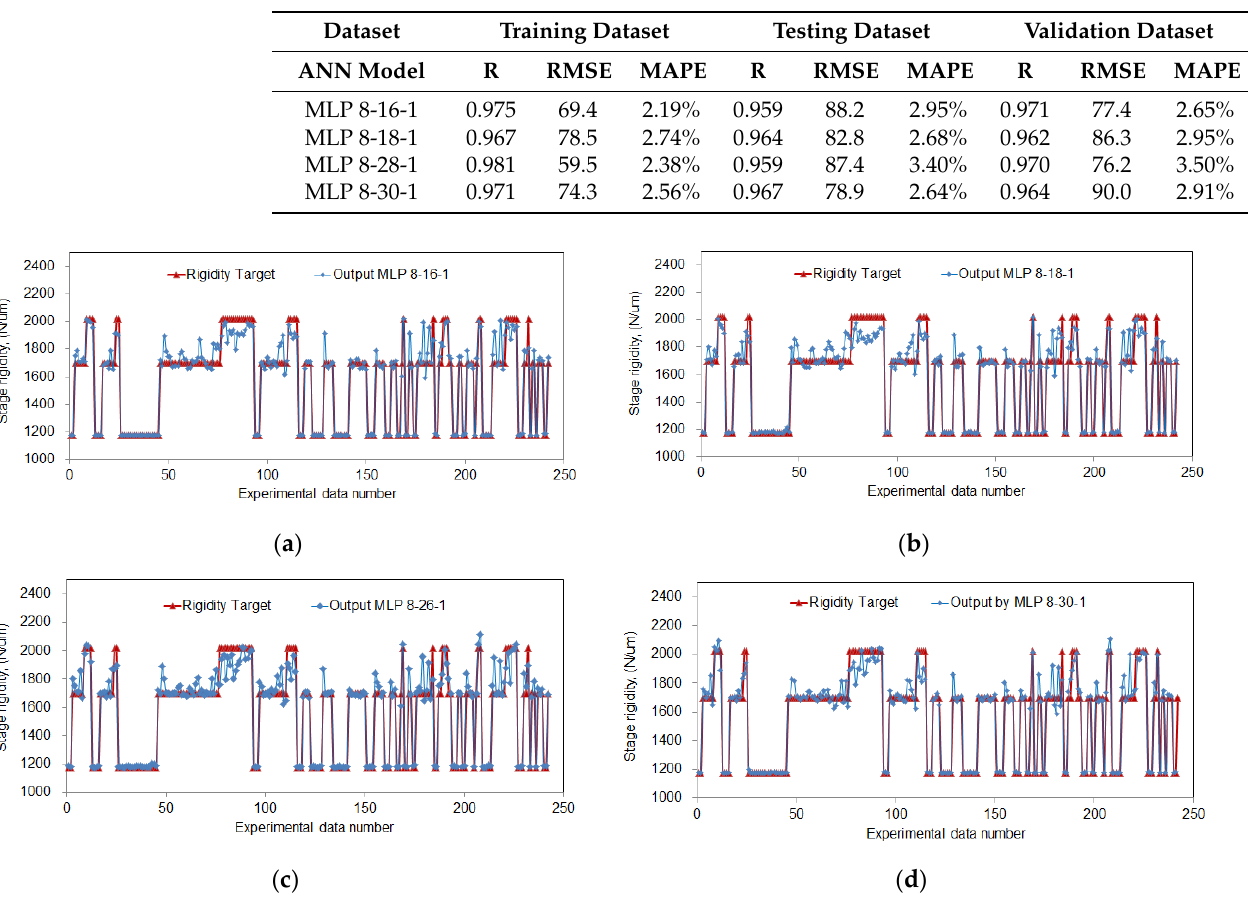
Table 7. Statistical values of neural network models.